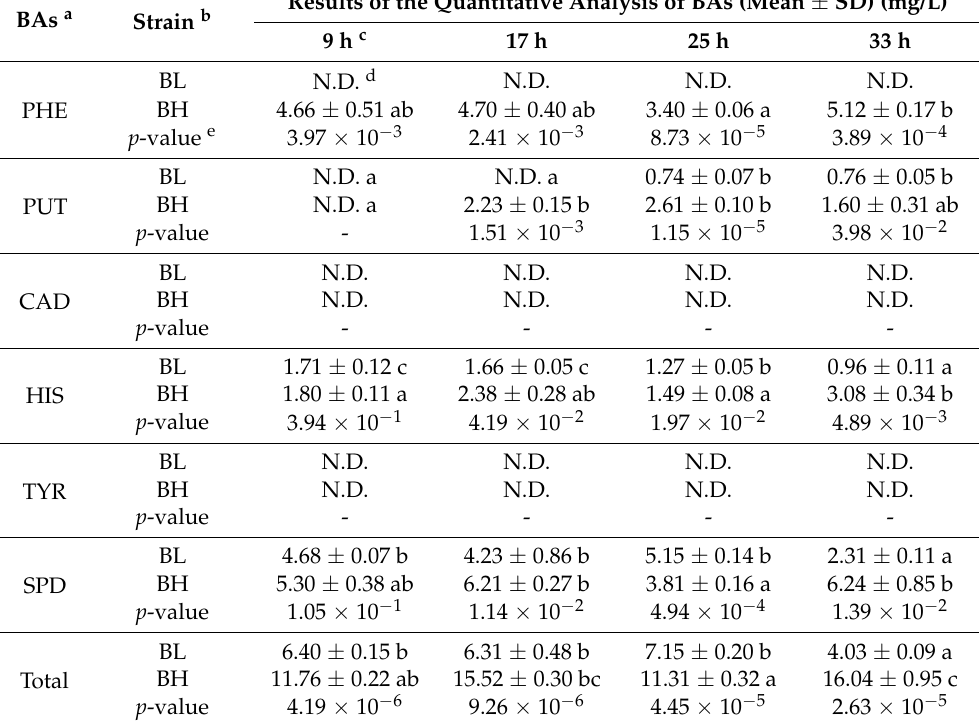
Table 1. Quantitative results of biogenic amines (BAs) concentration. BAs